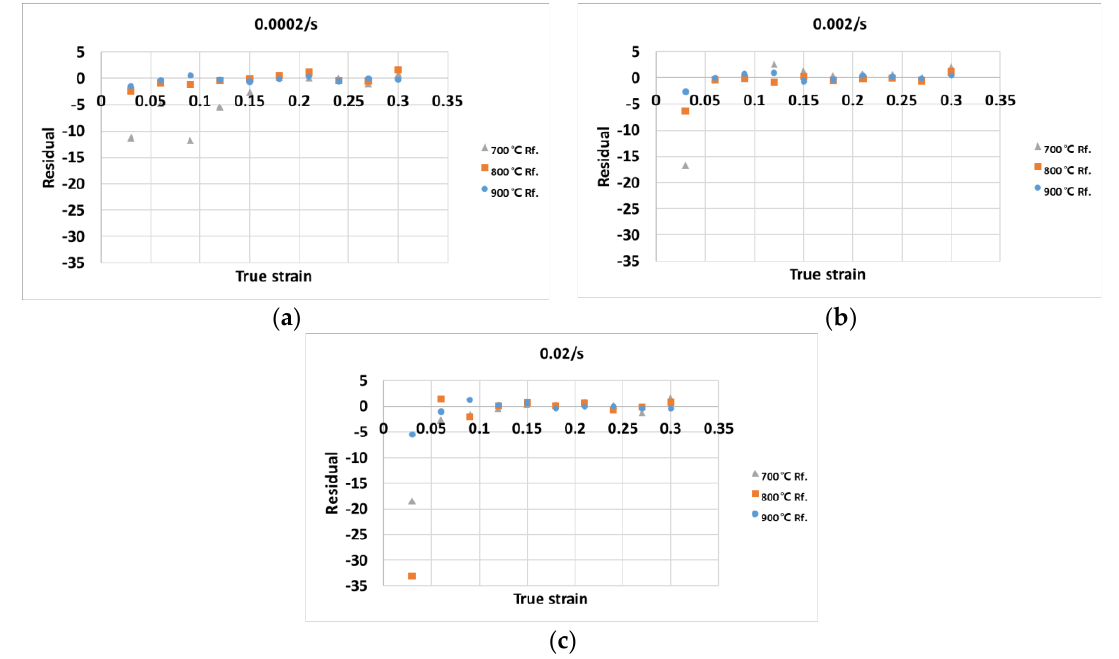
Figure 7. Residual plots of the predicted stress by the random forest algorithm at ( a ) the strain rate 0.0002/s, ( b ) strain rate 0.002/s, and ( c ) strain rate 0.02/s.